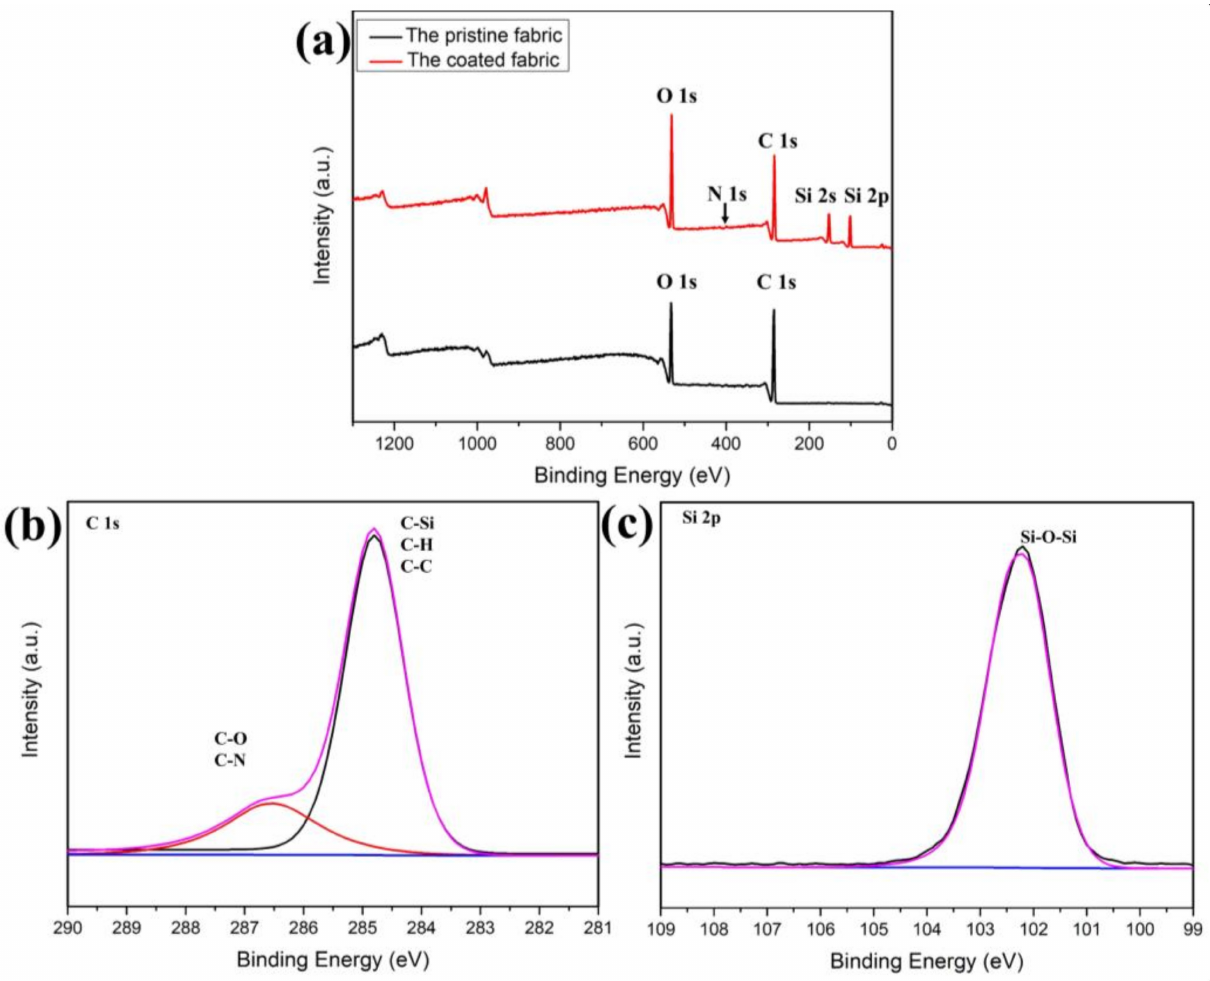
Figure 2. XPS spectra of cotton fiber before and after finishing. ( a ) High-resolution XPS spectra of C 1s ( b ) and Si 2p ( c